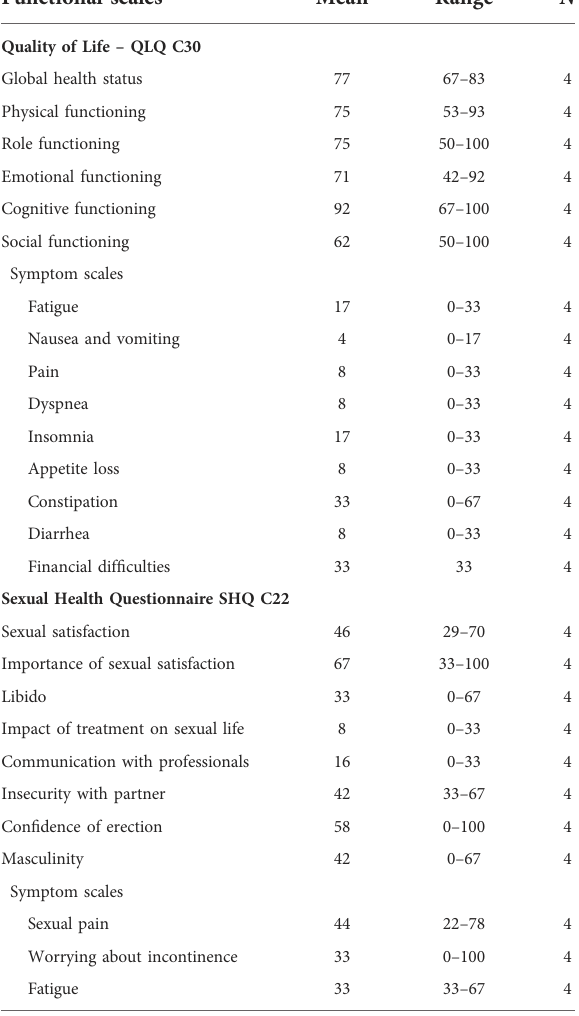
TABLE 3 Quality of life and sexual health questionnaires. Functional